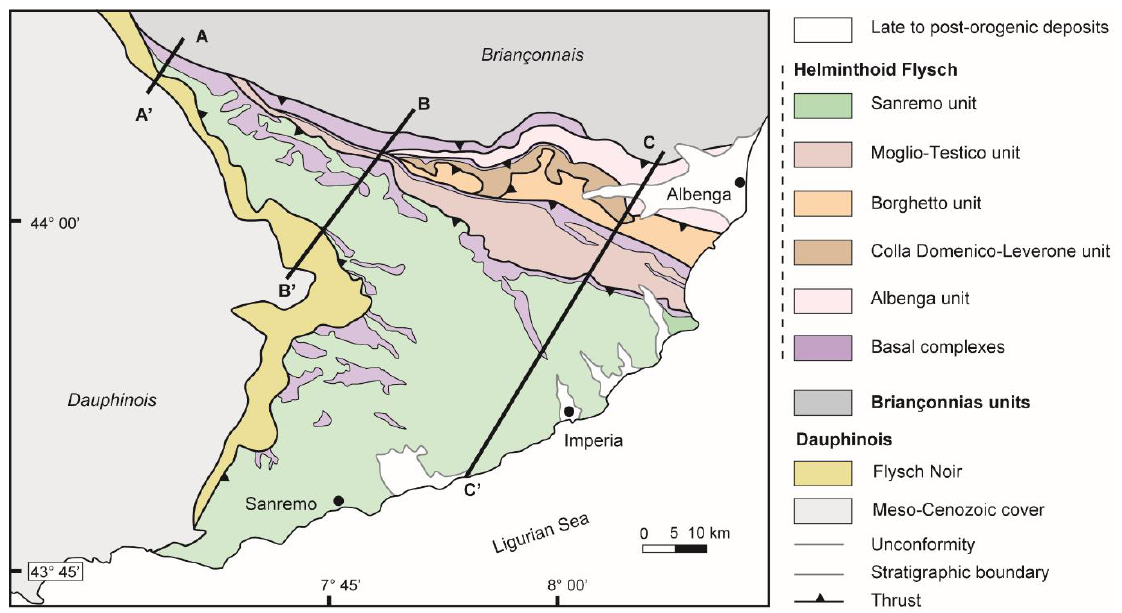
Figure 3. Simplified geological map of the Helminthoid Flysch nappes, from [32,37,40,41]. Location of cross-sections are shown.